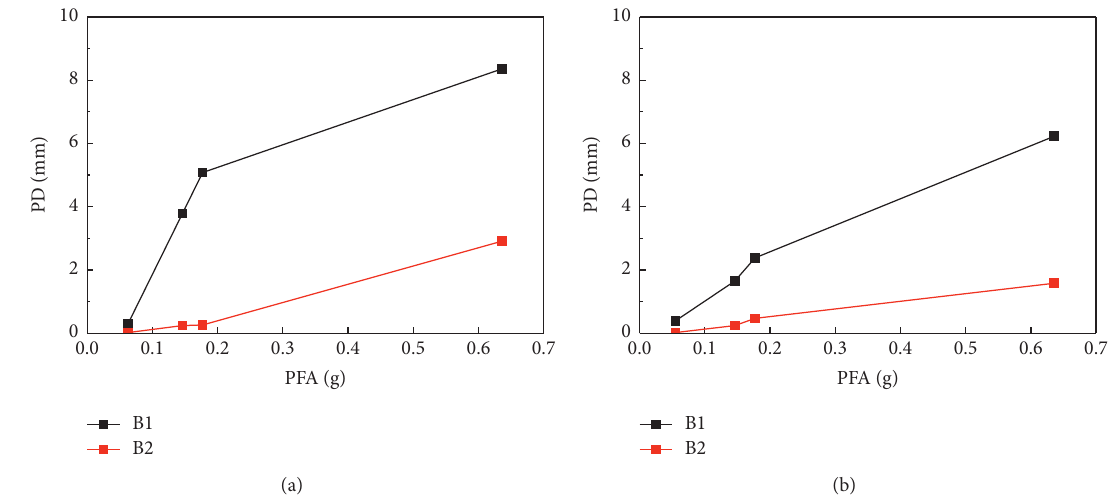
Figure 16: Peak displacement under earthquake waves. (a) Response in X direction and (b) response in Y